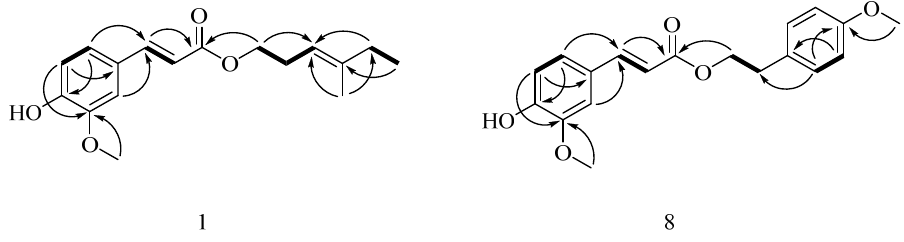
Figure 2. 1 H– 1 H COSY ( − ) and key HMBC ( → ; from H to C) correlations of compounds 1 and 8 .